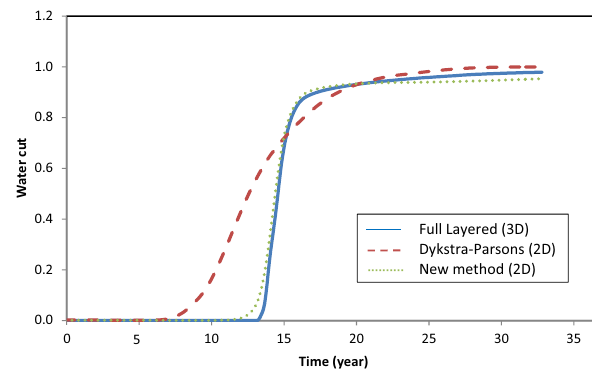
Fig. 8 Water cut comparison for constant flow rate case